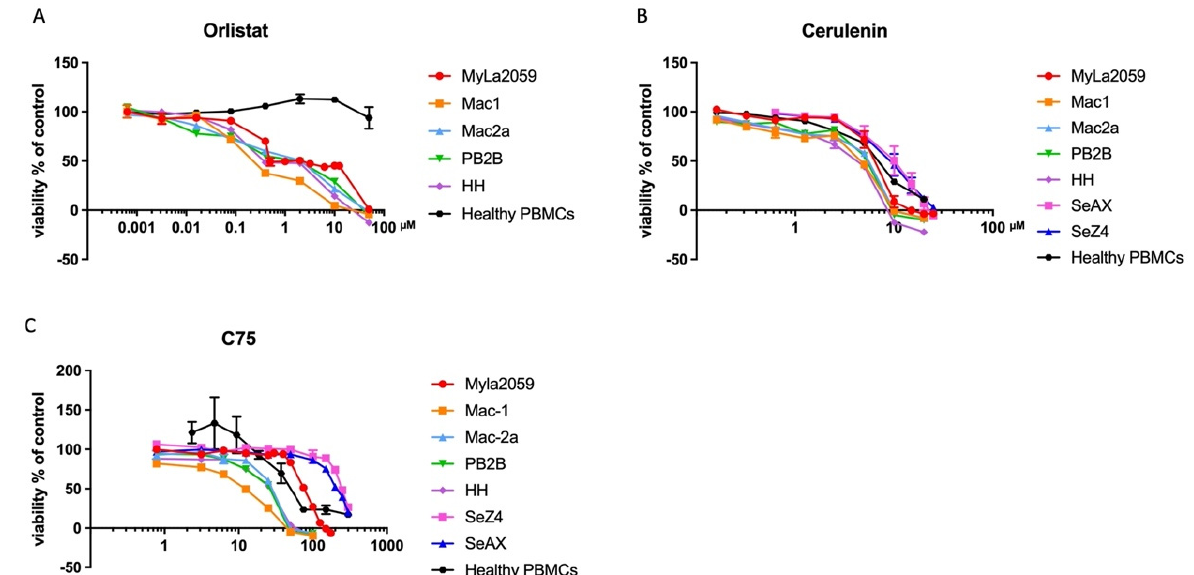
Figure 2. Inhibition of FASN reduces the viability of CTCL cell lines. CTCL cell lines and PBMCs from healthy donors were treated with three different FASN inhibitors; ( A ) Orlistat, ( B ) Cerulenin, and ( C ) C75. After incubation for 48 h, cell viability was analysed by MTT assay as described in material and methods. All the CTCL cell lines showed similar sensitivity towards Orlistat, Cerulenin, and C75, but Orlistat did not affect healthy PBMCs. The concentration ranges for Orlistat were: 0.00064 µ M–50 µ M, Cerulenin: 0.16 µ M–25 µ M, and C75: 0.78 µ M–300 µ M, respectively.